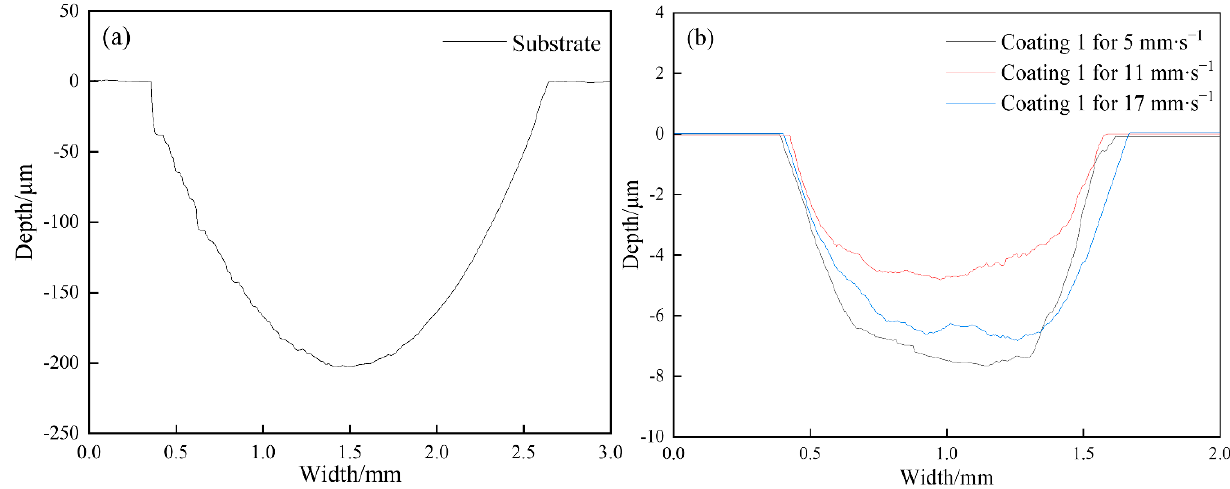
Figure 9. Representative wear profiles of substrate ( a ) and the coatings ( b ).